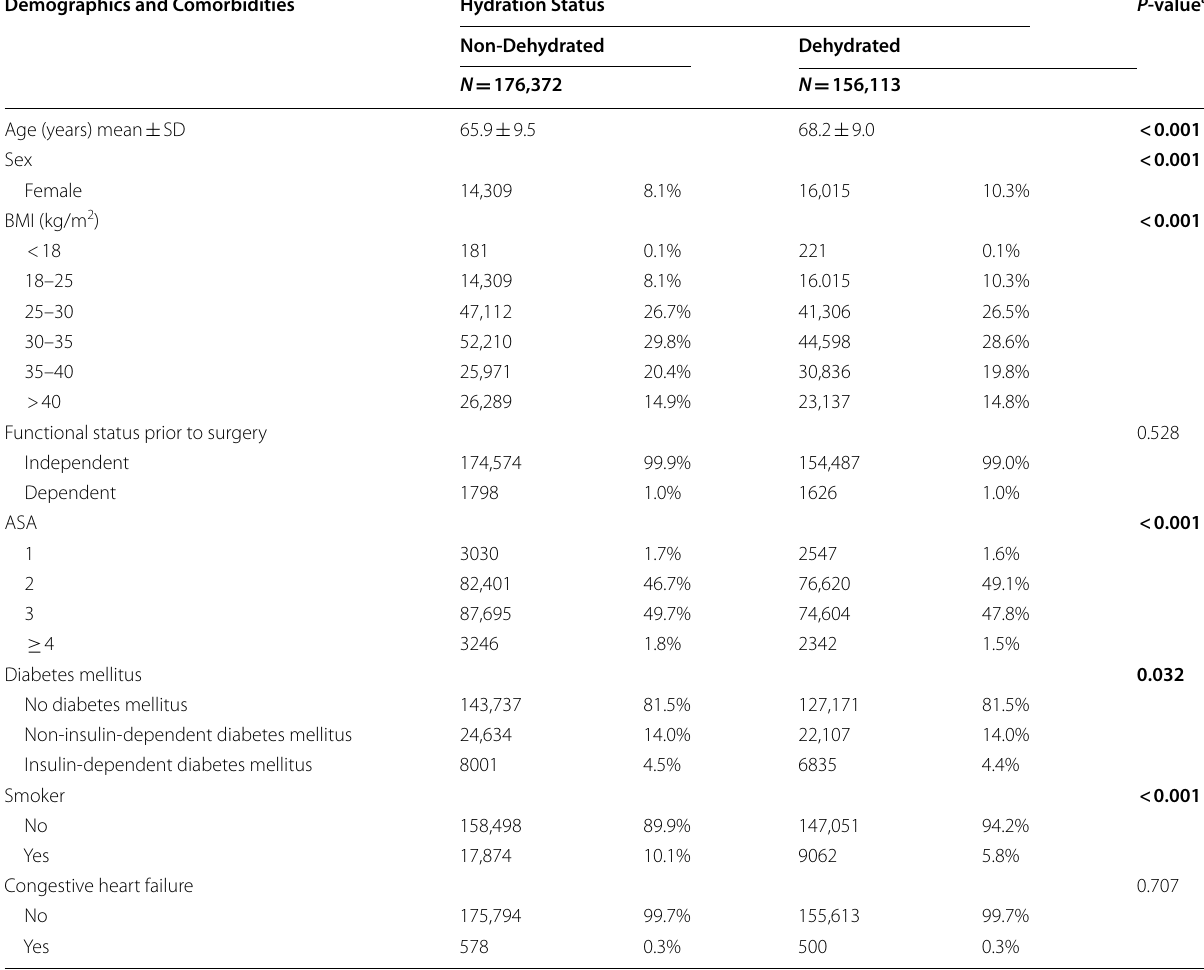
Bold fonts indicate statistical significance. a Statistical significance set at P <